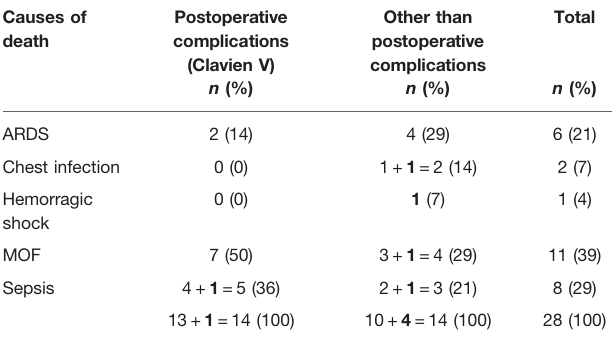
TABLE 3 | Causes of death — anytime ( n =28 death).